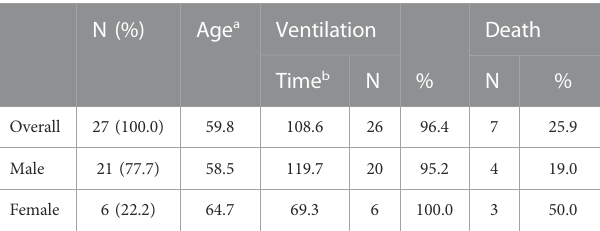
TABLE 1 Demographic characteristics of patients. TABLE 2 Patients with a fatal